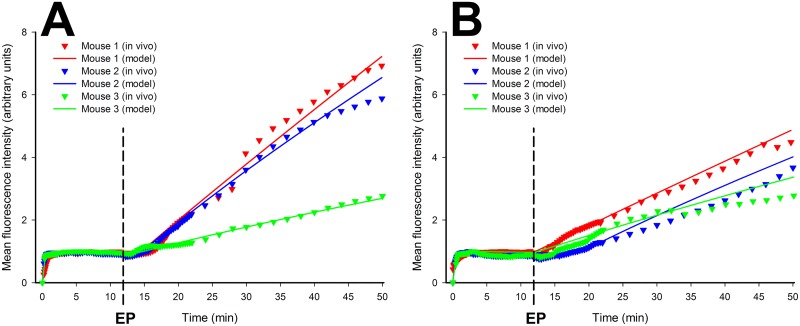
Mean fluorescence intensity vs. time curve fitting of in vivo experimental data.Mean fluorescence intensity vs. time curve fitting of in vivo experimental data for 70 kDa (A) and 2000 kDa (B) FD extravasation from the blood vessels. Triangles in A and in B represent data from in vivo experiments obtained for 70 kDa and 2000 kDa FD, respectively. The solid lines in both figures represent the time curve fitted data from the model for each mouse separately.